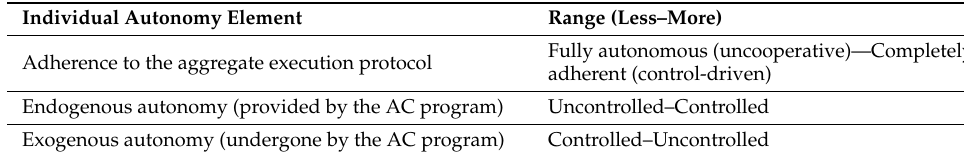
Table 2. Individual autonomy in aggregate